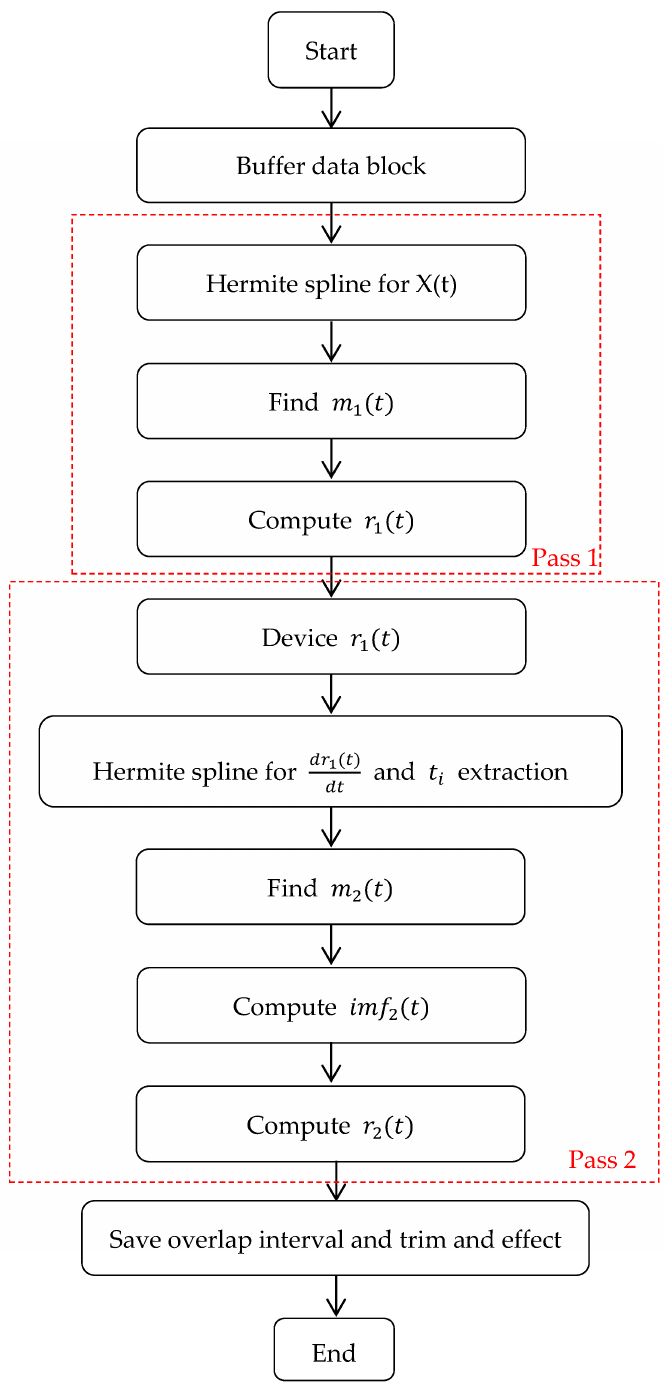
Figure 7. Flow chart of LWEMD for harmonic extraction. Table 6. The LWEMD algorithm.